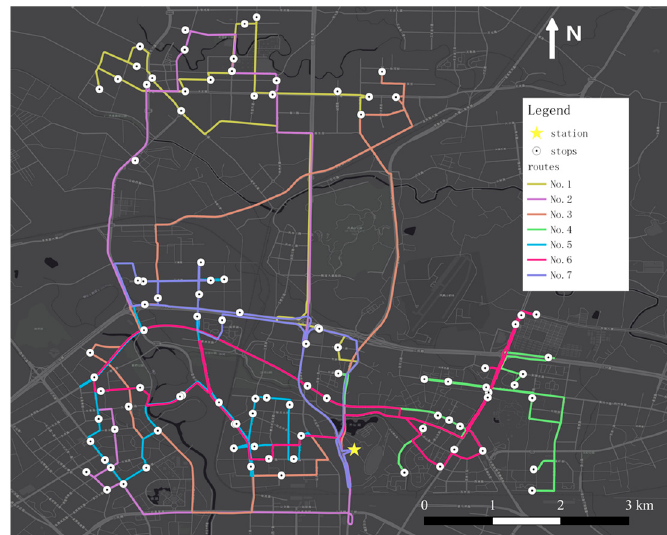
Figure 8. Generated shuttle service network. Table 4. Generated shuttle routes.